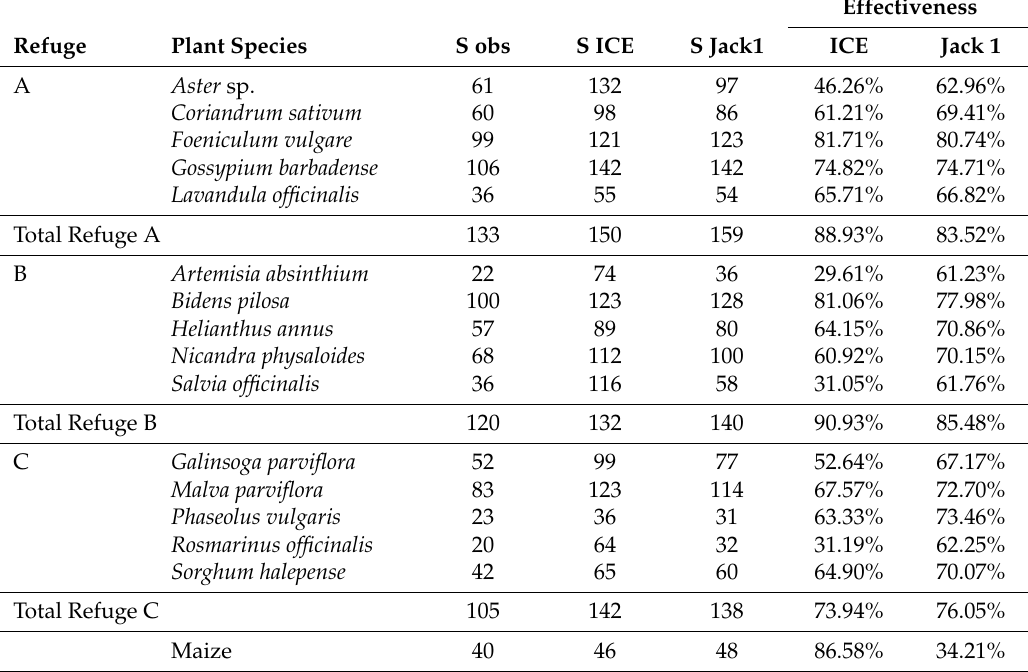
Table 3. Number of species observed (S obs) and predicted by the two estimators (S ICE, S Jack1) in every plant species, including maize crops, and every refuge. Sampling effectiveness is presented as the proportion of observed species to the estimated